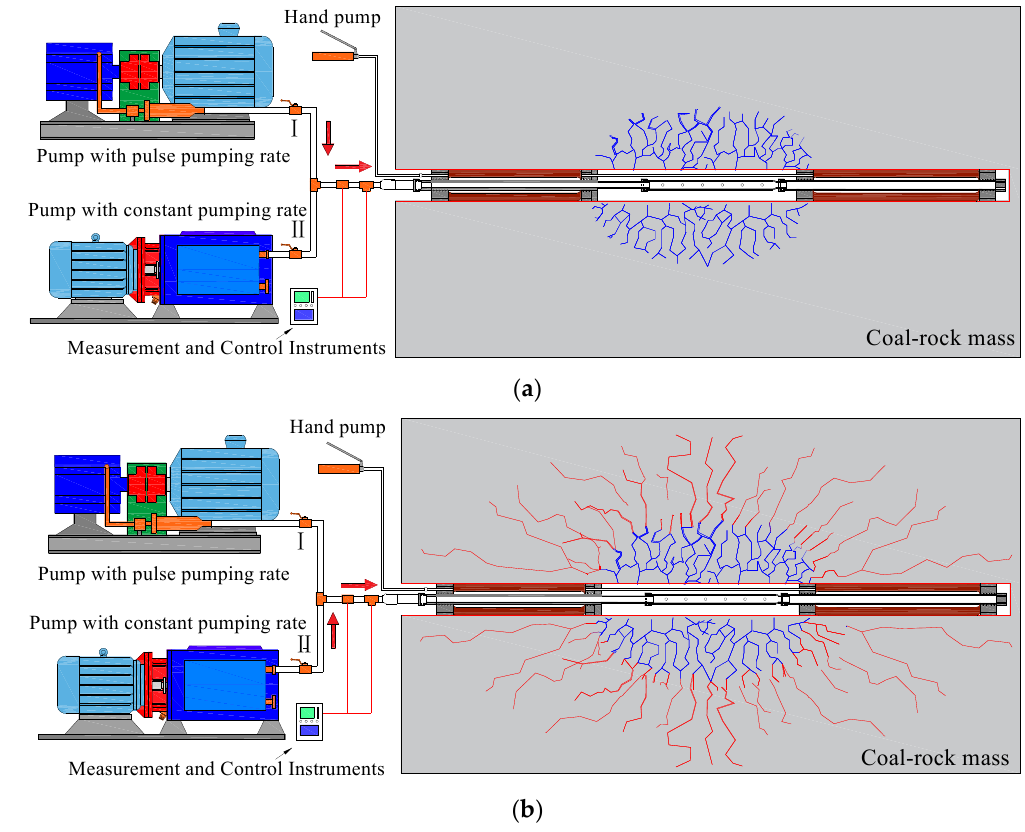
Figure 4. Technology process of combining pre-pulse and constant pumping rate hydraulic fracturing: ( a ) pulse hydraulic fracturing and ( b ) conventional hydraulic fracturing with constant pumping